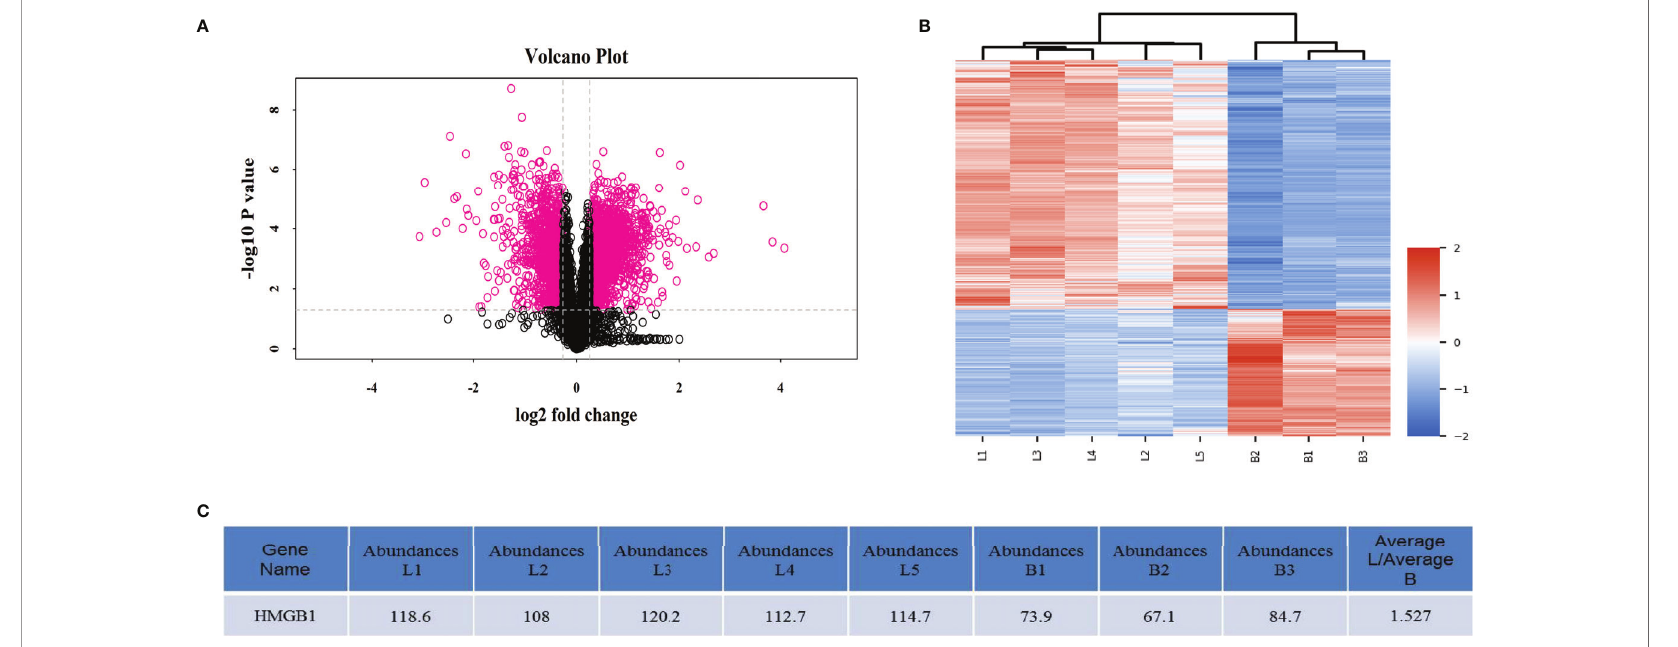
FIGURE 2 | MALDI-TOF pro fi ling data obtained from three syngeneic liver grafts and fi ve allogeneic liver grafts. (A) Volcano plots of differentially-expressed proteins. The x-axis represents the negative log (base 10) of the adjusted p-value and the y-axis represents the log (base 2) of fold change. The dots in pink denote differentially-expressed proteins. Overall, 3276 differentially-expressed proteins including HMGB1 were identi fi ed by mass spectrometry. (B) Heatmap plots of the differentially-expressed proteins. The horizontal axis represents the samples and the upper horizontal axis represents the sample clusters. The vertical axis represents the differentially-expressed proteins and the left vertical axis shows the clusters of differentially-expressed proteins. L1 – 5 represents the fi ve allogeneic liver grafts and B1 – 3 represents the three syngeneic liver grafts. Red represents upregulated proteins and blue represents downregulated genes. (C) HMGB1 expression was elevated in the allogeneic liver